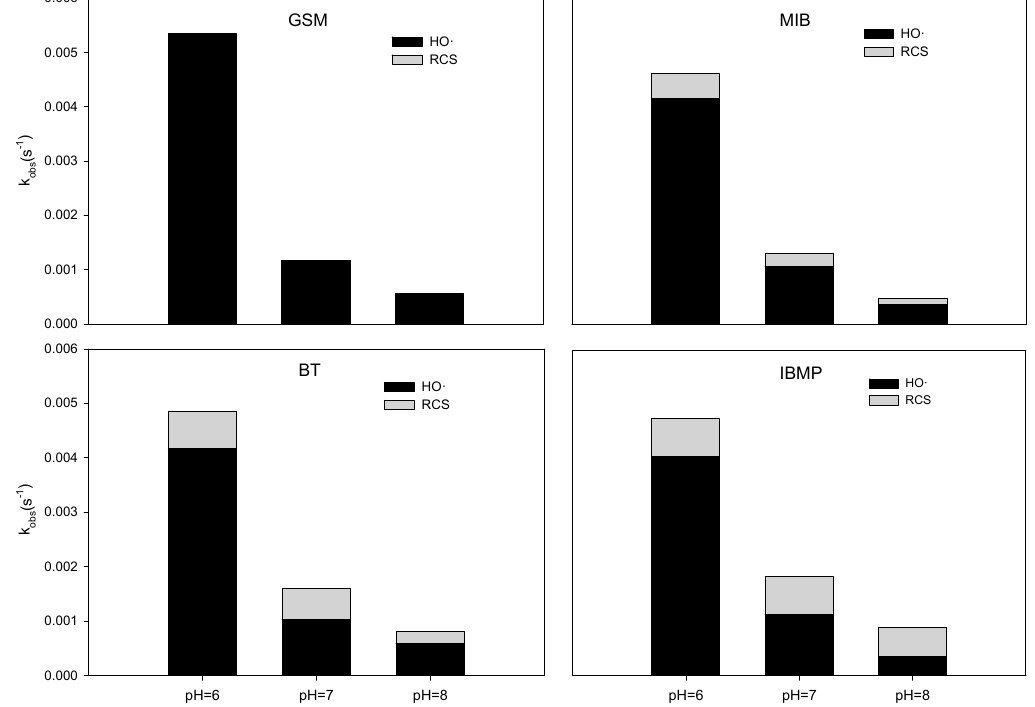
Figure 4. Pseudo-first-order rate constants (k obs ) of the degradation of T&O compounds by HO • Figure 4. Pseudo ‐ first ‐ order rate constants (k obs ) of the degradation of T&O compounds by HO• and